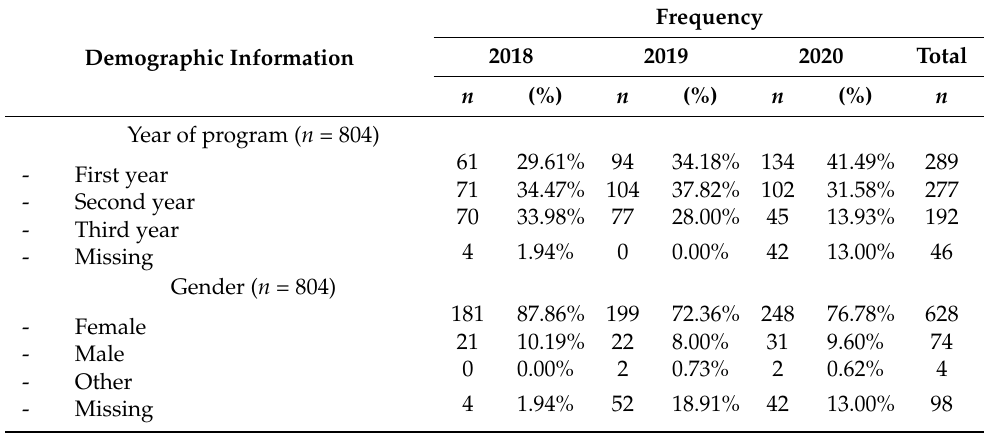
Table 2. Participant